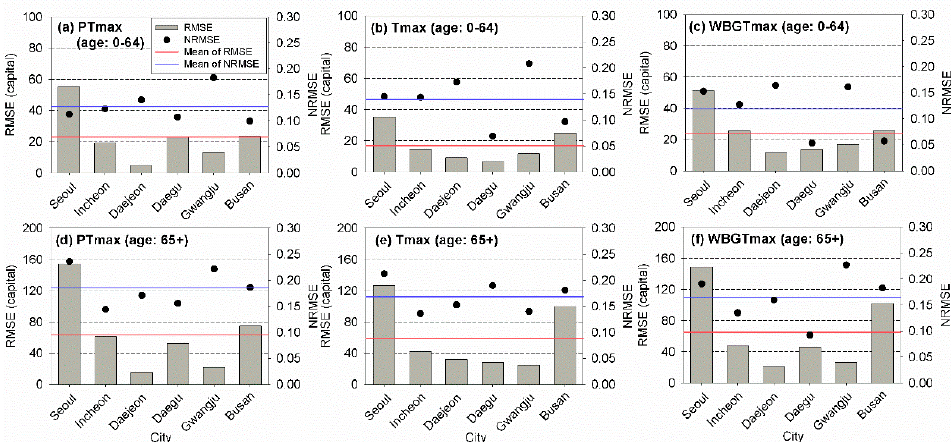
Figure 9. Root-mean-square error (RMSE) and normalized RMSE of the observed and estimated annual total mortalities for young people with ( a ) PTmax, ( b ) Tmax, and ( c ) WBGTmax and elderly people with ( d ) PTmax, ( e ) Tmax, and ( f ) WBGTmax for the six cities and young (0–64) and elderly (64 + ) people for the training period (2000–2016).